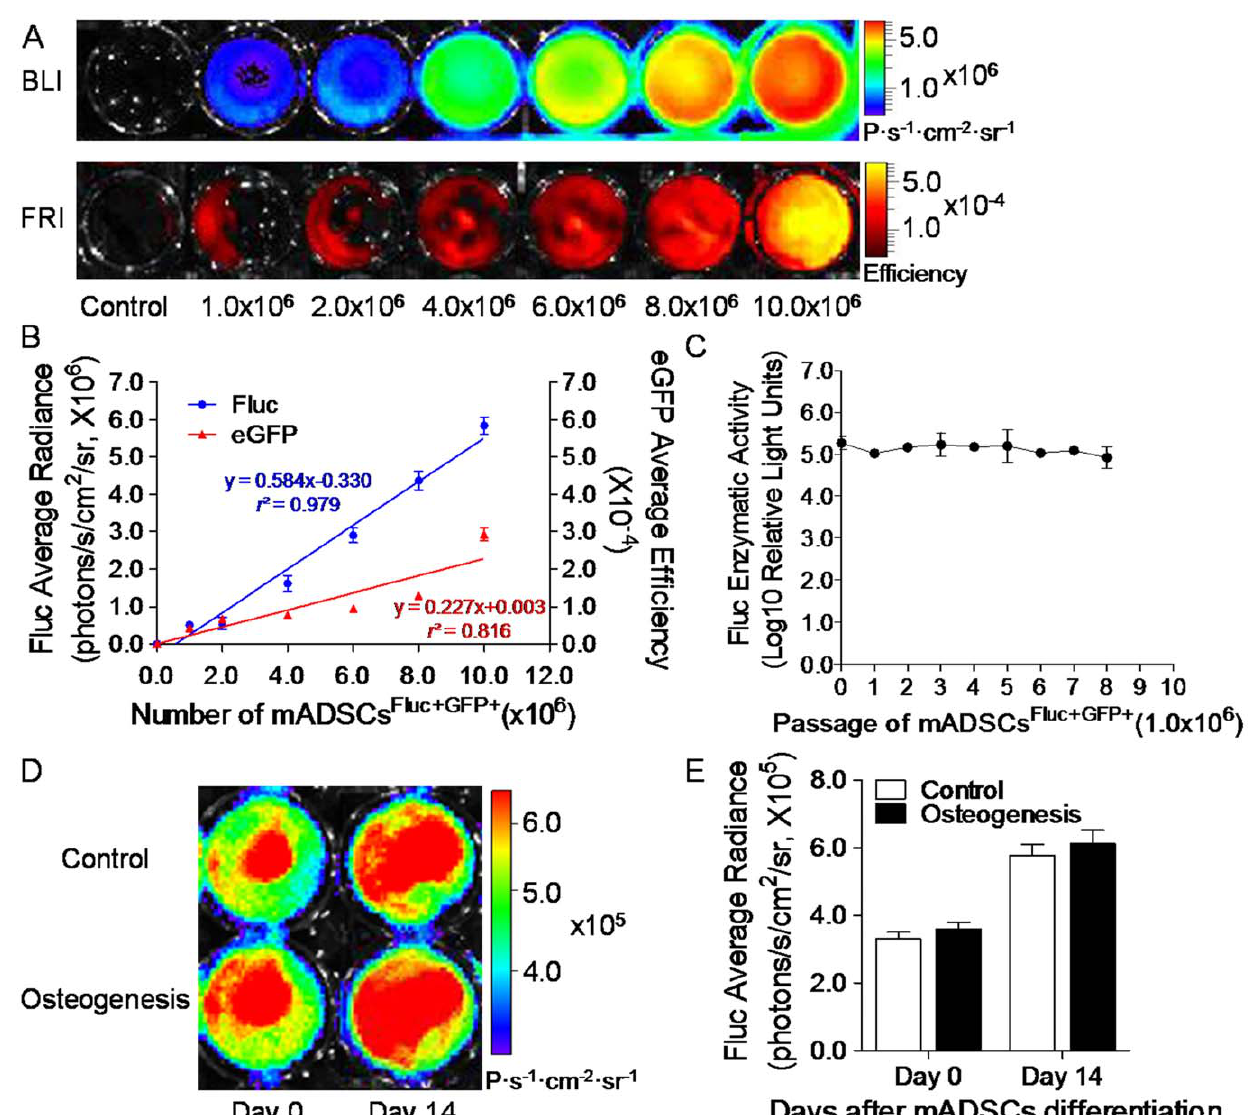
Figure 2. mADSCs Fluc + GFP + quantification by reporter gene imaging. Representative bioluminescence/fluorescence images of mADSCs- Fluc + GFP + in vitro ( a ). Linear correlation of cell quantities with optical signal of firefly luciferase (Fluc) and eGFP is displayed, with correlation coefficient r 2 values and linear functions ( b ). The Fluc enzymatic activity of mADSC Fluc + GFP + was stable in 8 passages ( c ). BLI ( d ) and quantification ( e ) of mADSCs Fluc + GFP + over osteogenesis induction or normal culture (control) for 14 days. Colored scale bars represent Fluc bioluminescence intensity in photons/second/cm 2 /steridian (P ? s 2 1 ? cm 2 2 ? sr 2 1 ), and eGFP fluorescence intensity in efficiency. n=20 for each. Error bars: mean 6 SD.